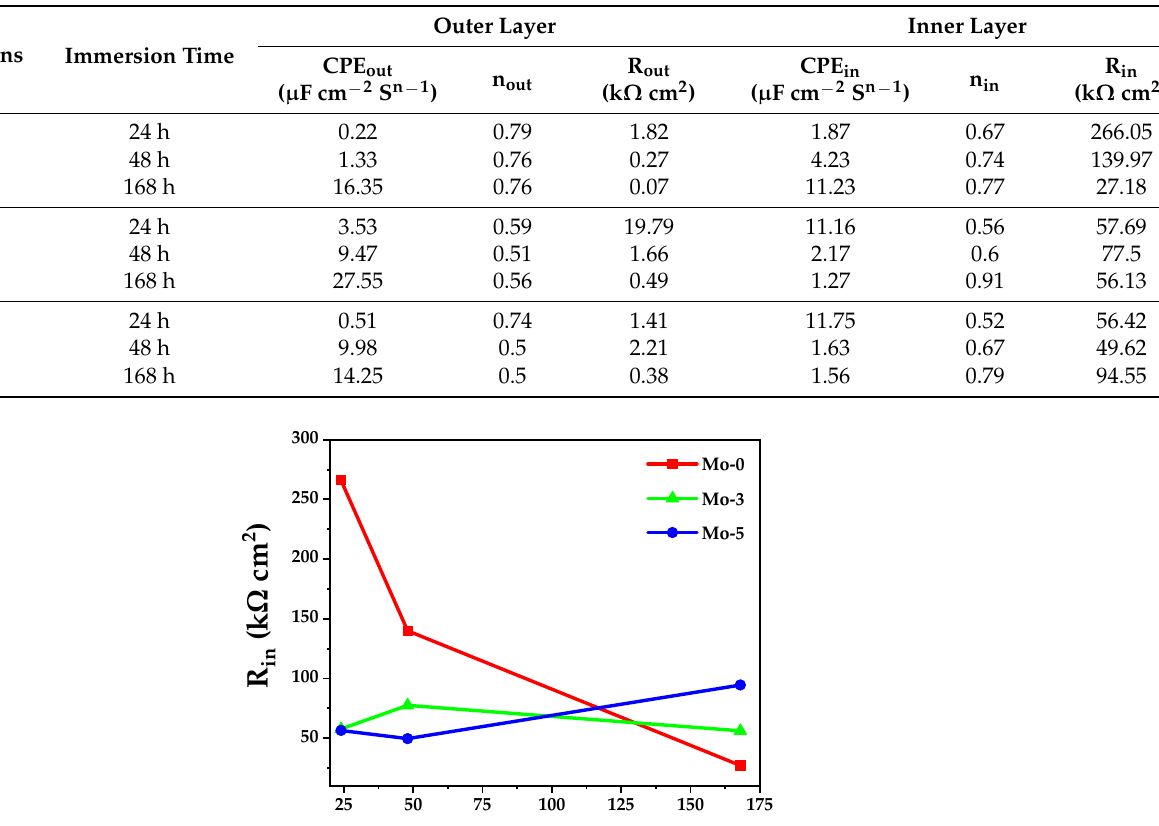
Figure 9. The electrical equivalent circuit was used for fitting the EIS data. Table 3. Electrical elements extracted from EIS plots using Zview software for Mo-0, Mo-3, and Mo-5 specimens.